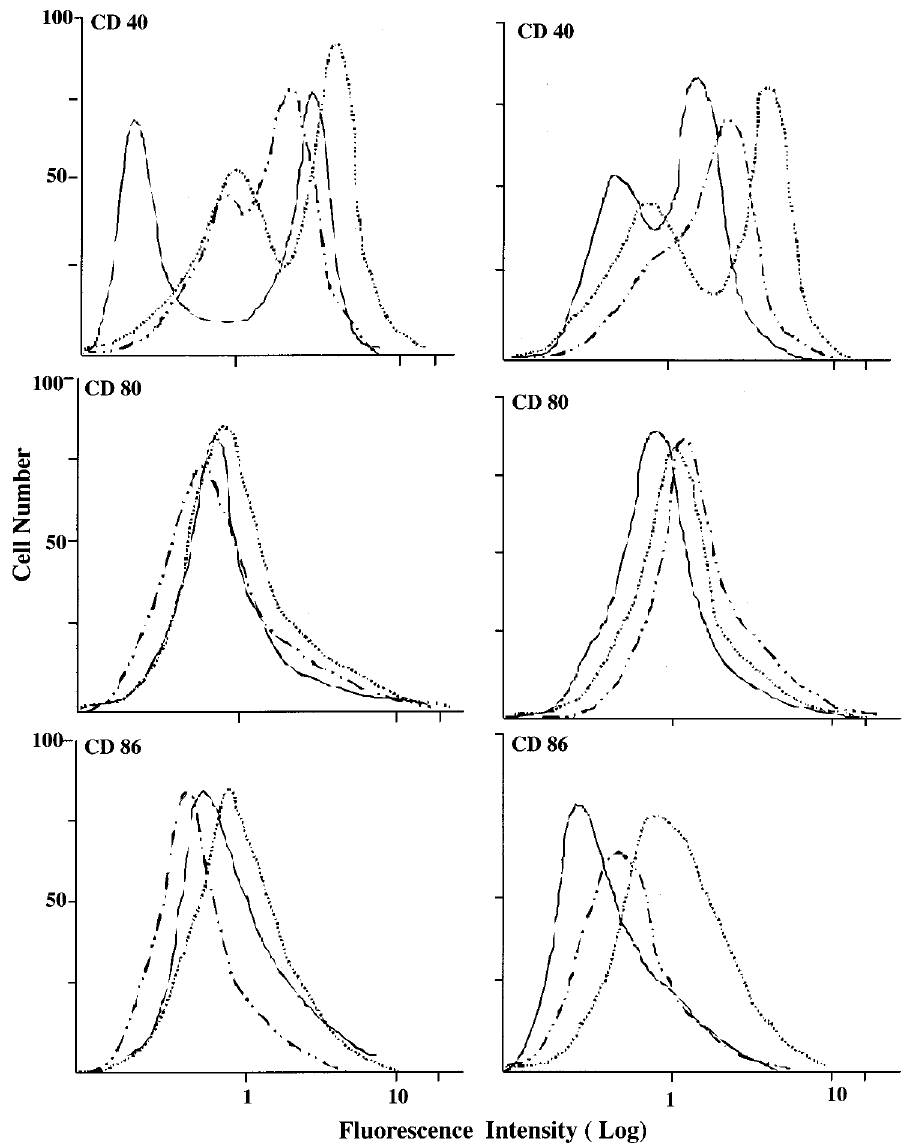
FIG. 6. Influence of oral RXM treatment for 4 weeks on co-stimulatory molecule expressions induced by antigenic stimulation in vivo . BALB/c mice were immunized by intraperitoneal injection with 8.0 m g/ml of hemocyanin absorbed to 4.0mg of aluminum hydroxide in a volume of 0.5ml. The mice were orally administered with 2.5mg/kg of RXM once a day for 4 weeks starting 7 days after immunization. Splenic B cells were prepared from mice 24h after challenging immunization. The expression was analyzed by flow cytometer: (____ ) non-treated and non-challenged control, (. . . . .) non-treated and challenged, (_ . . _ . . _ ) treated and challenged. Left panels, non-immunized mice; right panels, immunized